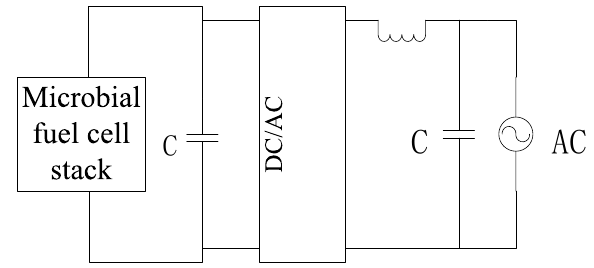
Figure 6. Three-phase voltage type inverter circuit.